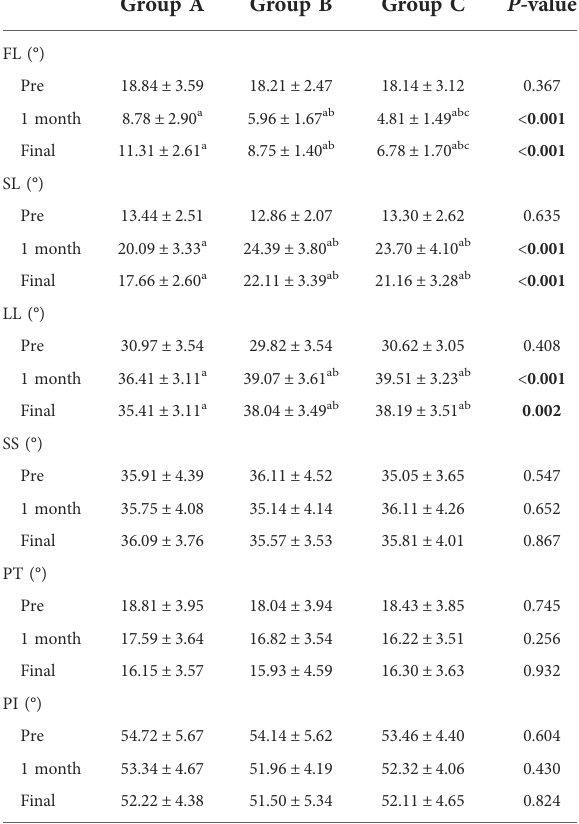
TABLE 2 The radiographic data of groups.